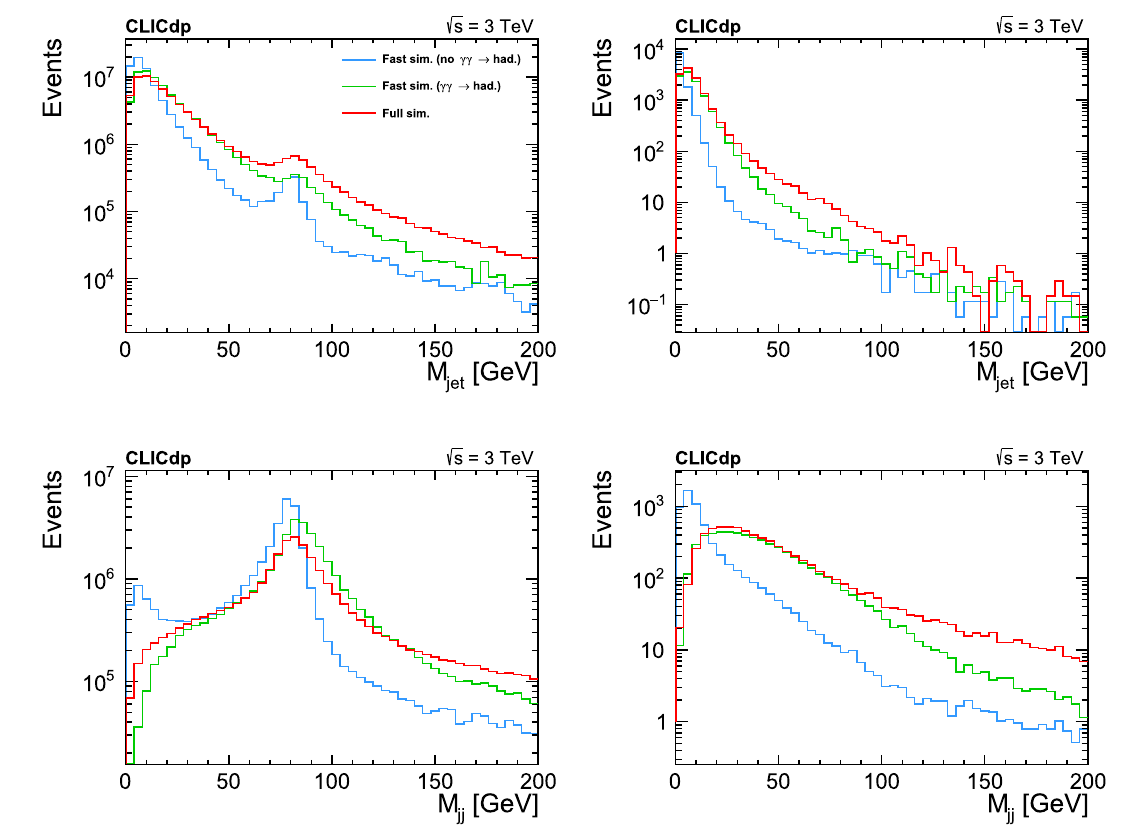
Fig. 2 Histograms of the masses of a single jet (upper row) and of a dijet system (bottom row), for the qq ℓν background (left) and HP17 signal (right) samples at 3TeV. Results of the Delphes simulation without (blue histogram) and with (green) the overlay event contribution are compared with results of the full detector simulation (red)